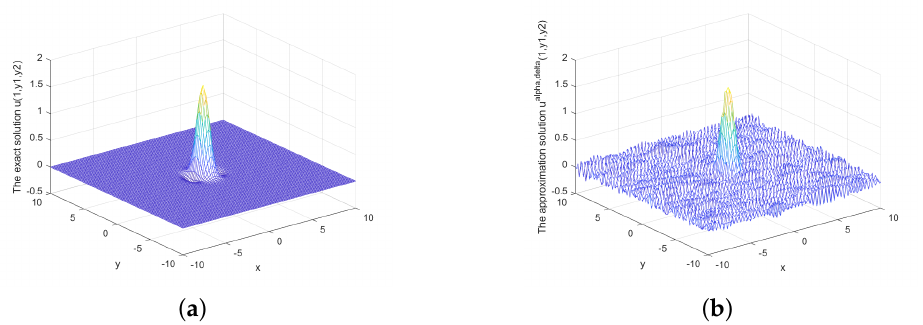
Figure 4. ( a ) The exact solution and ( b ) the regularized solution when x = 0.5, δ = 1 × 10 − 5 under prior rule.